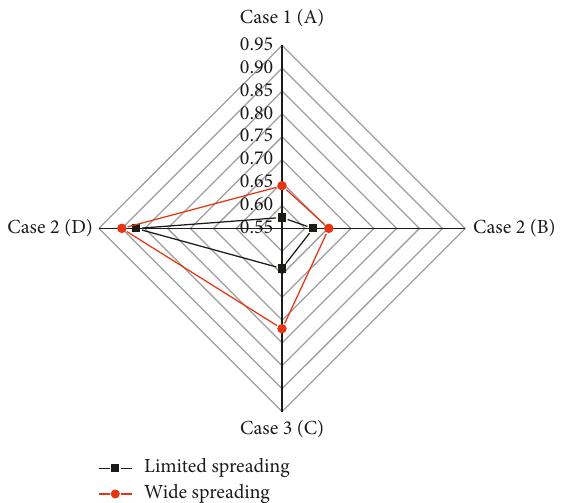
Figure 5: Comparison of the guidance effects of key agents in different cases, and the radar chart shows the difference in the result of limit and wide